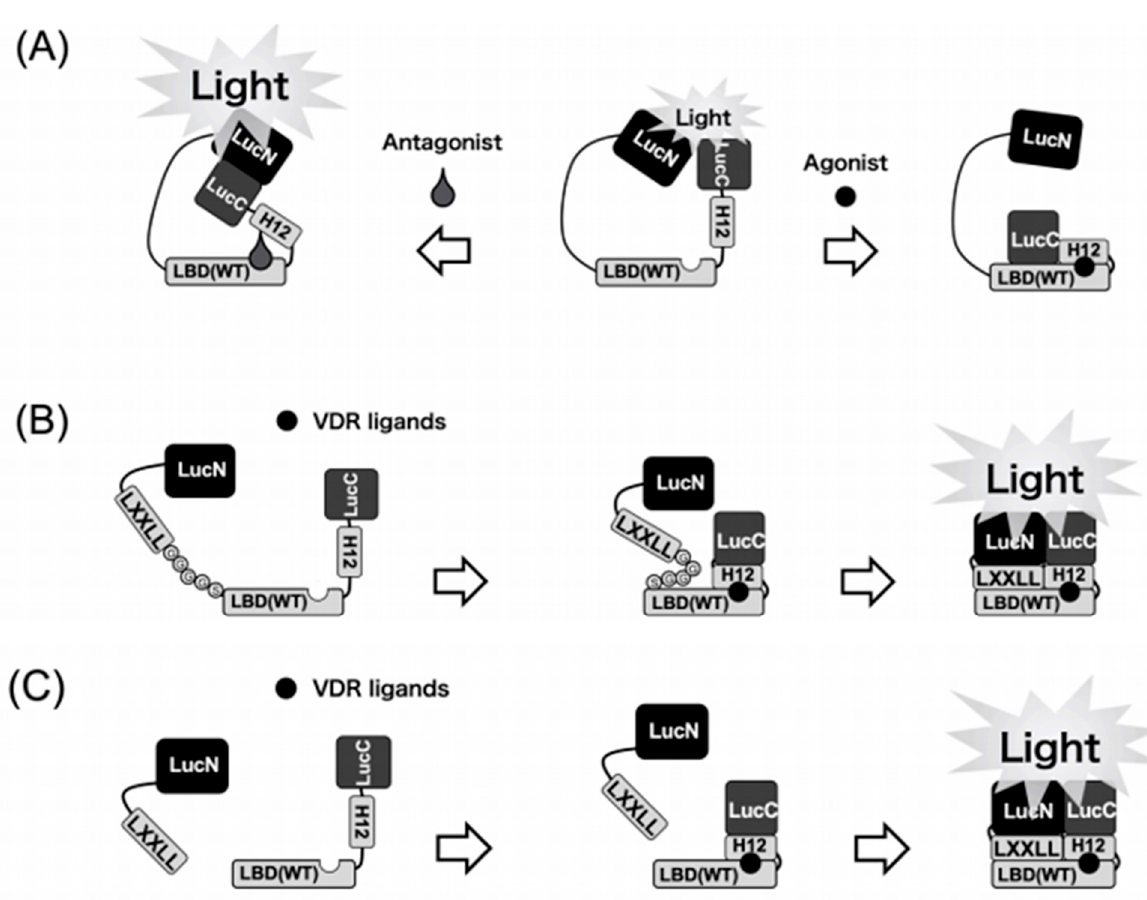
Figure 1. Schematic diagrams of the biosensors to detect VDR ligands. ( A ) 1st generation. Binding of the VDR agonists to the LBD may cause a conformational change of the LBD that leads to disruption of the functional complex between N-terminal and C-terminal domains of the luciferase. In contrast, binding of the antagonist leads to the reassembly of N-terminal and C-terminal domains of the luciferase to increase the activity. ( B ) 2nd generation. Binding of VDR ligands to the biosensor may cause a conformational change of helix12 (H12) in LBD. After conformational change of LBD, the LXXLL motif interacts with LBD in the biosensor. Then, this intramolecular dynamic change of the WT biosensor leads to reconstitution of the functional complex between LucN and LucC fragments of the split luciferase. ( C ) 3rd generation. Binding of the VDR ligands to the LBD–LucC may cause a positional change of helix12 in LBD. Then, the LucN–LXXLL and LBD–LucC forms a functional complex to exhibit the luciferase activity.